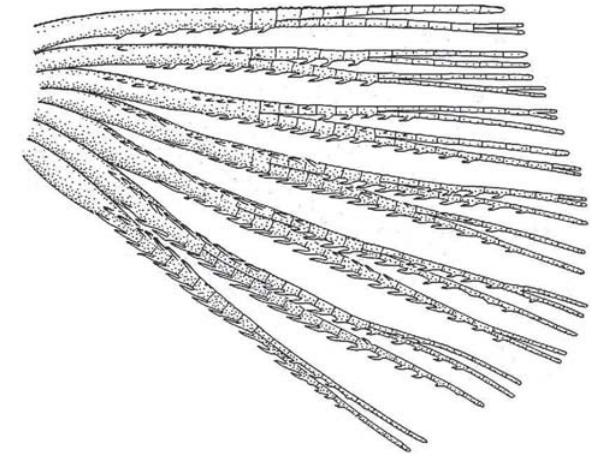
Fig. 84. Mimagoniates microlepis , adult male, USNM 249885, 41.2 mm SL; pelvic-fin rays, ventral view, left side. All rays with fewer branches compared to those of large adult male in Fig. 83.